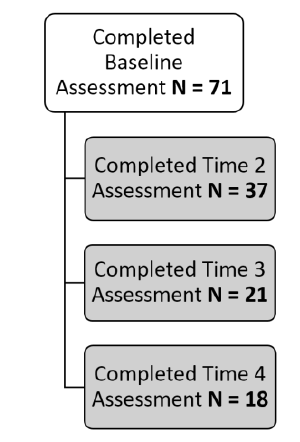
Figure 1 : Completion of Assessments for Attending Mindfulness Meditation Program during the School Year. Flow chart of number of participants completing assessments throughout the MM